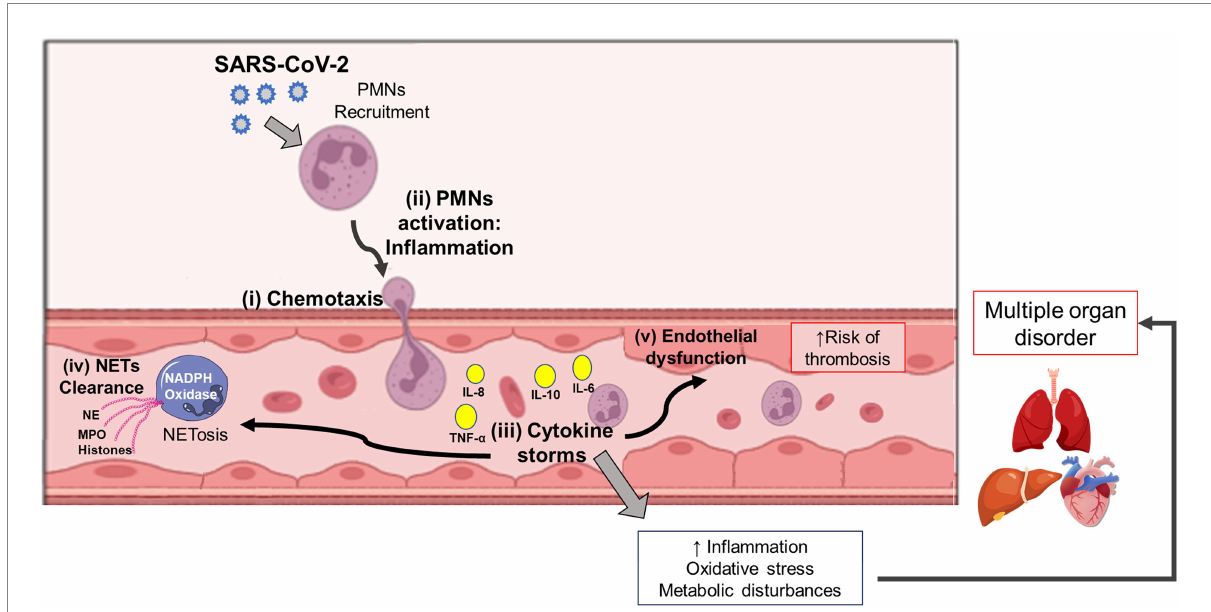
FIGURE 3 Interplay among Neutrophil, Cytokine Storm, AND Multi-Organ Dysfunction In Covid-19 Patients. Following the host-viral interaction, the SARS- CoV-2 conducts a signaling cascade of crosstalking among the virus recognition mechanism, neutrophil activation, and inflammatory stimuli. After chemotaxis and neutrophil (PMNs) recruitment (i), it occurs cell activation followed by inflammation (ii), and cytokine storm (iii). During these immune events, the NETosis process can protect the host during the virus response by NET clearance (iv). However, exacerbating hyperinflammation in COVID-19 patients is also possible, thus leading to endothelial dysfunction (v), oxidative stress, and metabolic disturbances, which can later result in multiple organ disorders. SARS-CoV-2: severe acute respiratory syndrome coronavirus-2; PMNs, neutrophils; NETs, neutrophil extracellular traps; TNF, tumor necrosis factor; IL, interleukin; NE, neutrophil elastase; MPO,